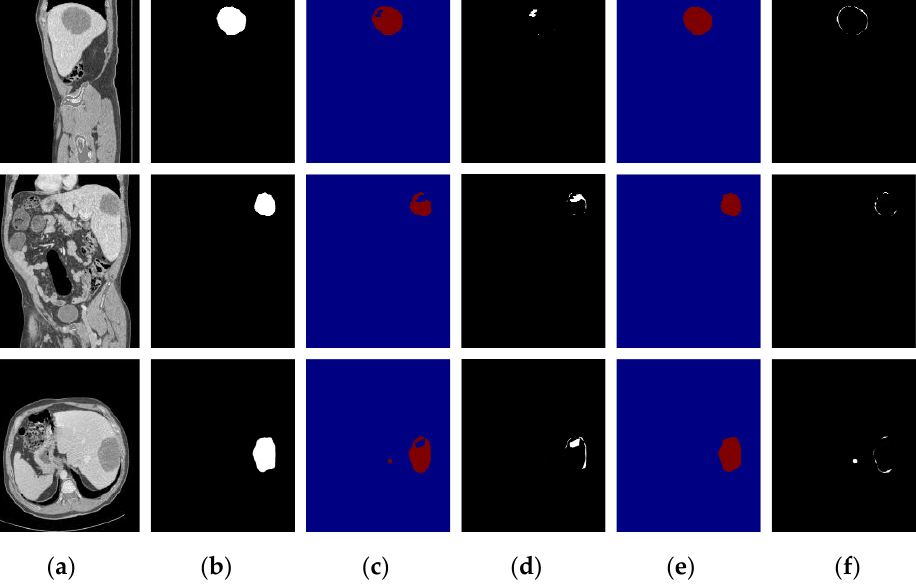
( f ) Figure 15. Segmentation result of a multiple-tumor area; the first row is the sagittal plane, the second row is the coronal plane, and the third row is the transverse plane. ( a ) CT image; ( b ) Ground truth; ( c ) DenseUNet segmentation results; ( d ) difference image between DenseUnet and ground truth; ( e ) the proposed algorithm’s segmentation results; ( f ) difference image between the proposed algo- rithm and ground truth. In this paper, we propose a two-stage liver and liver tumor segmentation algorithm for abdominal CT images, and the two stages are DCUNet-Liver and DCUNet-Tumor. We